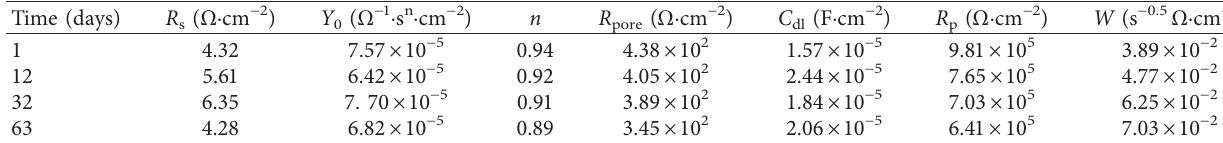
Table 5: Fitting results of the equivalent circuit obtained by fitting the EIS data.